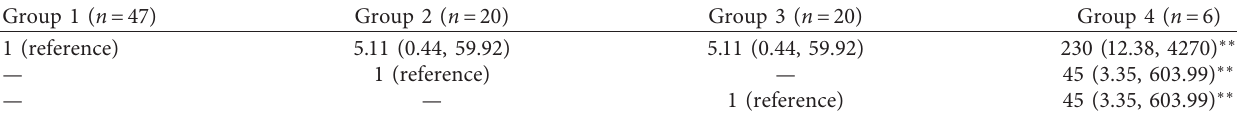
Table 4: Odds ratios of BMI b and Δ BMI for the follow-up MetS risk after 5